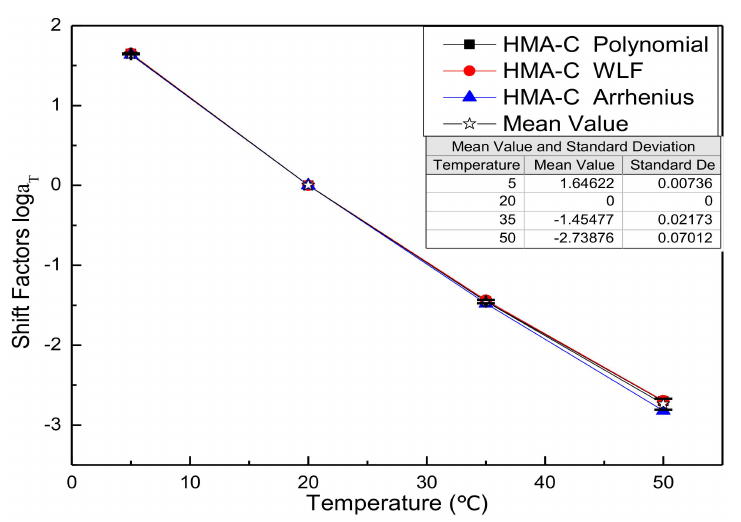
Figure 3. Shift factors of WMA-60.